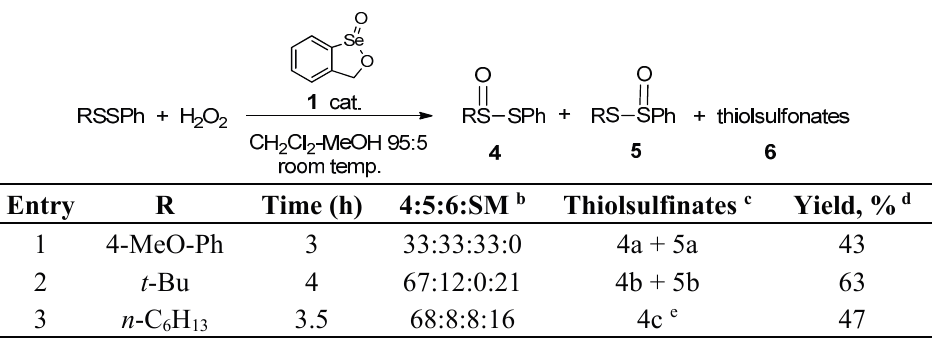
Table 3. Oxidation of unsymmetrical disulfides to thiolsulfinates 4 and 5 a